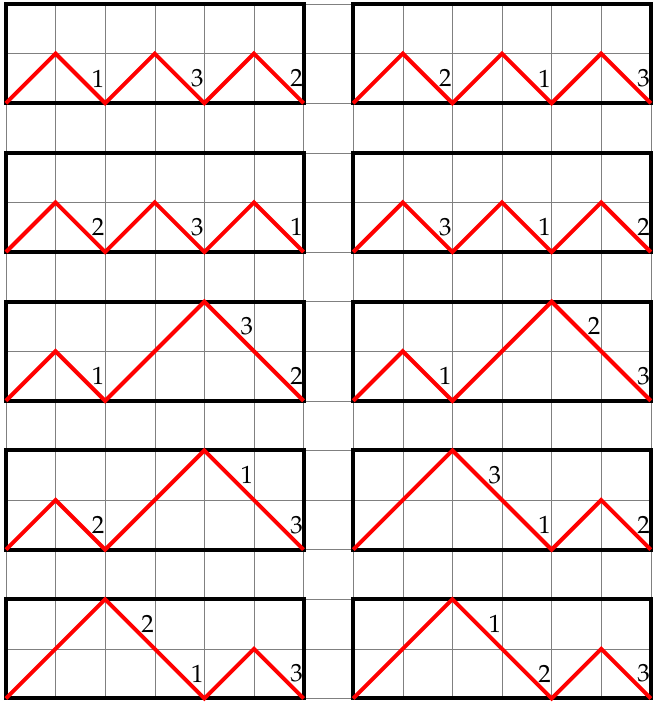
Figure 3. All labeled Dyck paths of size 3 with 1 ascent on return